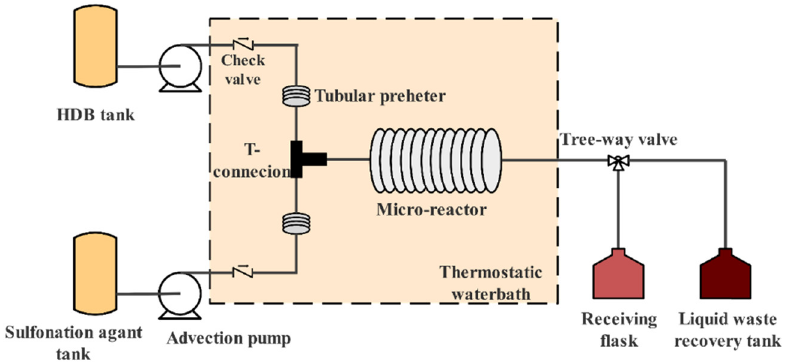
Figure 2: The schematic diagram of experimental